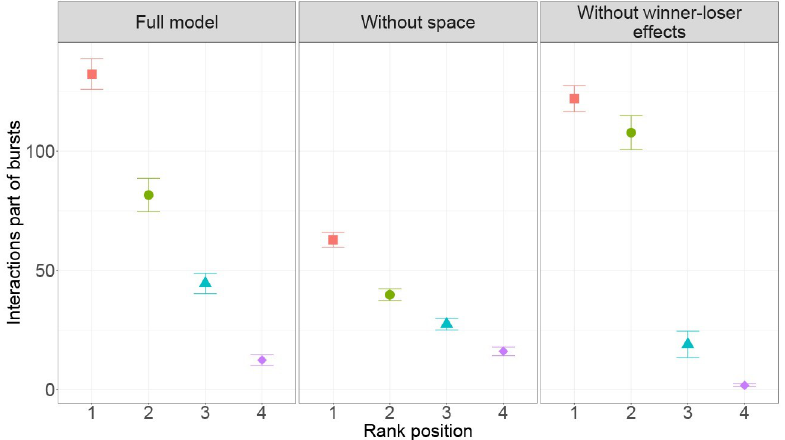
Fig 5. Average (and standard error, SE) number of interactions part of bursts per run. This is shown for each model version per rank position (rank 1 is most dominant).